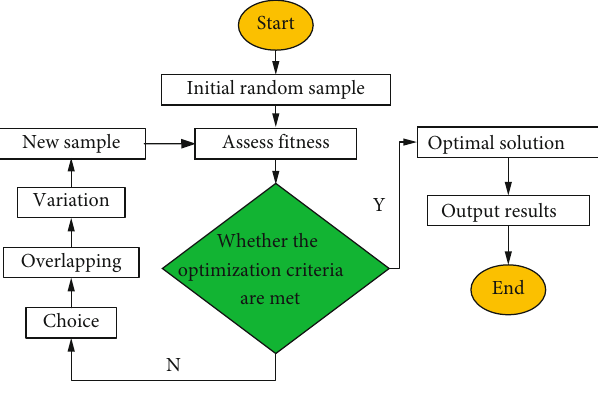
Figure 2: Chart of genetic